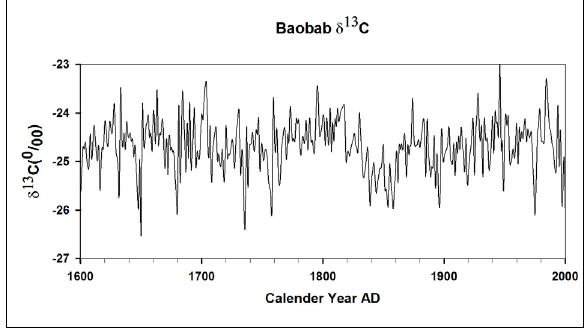
13 C tree ring data at annual intervals Figure 2: A plot showing the δ between 1600 AD and 2000 AD as obtained by Woodborne et al. 17 from baobab trees in the Pafuri region of southern Africa.